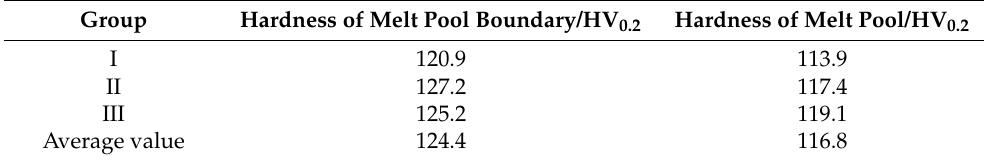
Table 4. Hardness test results of deposited state.